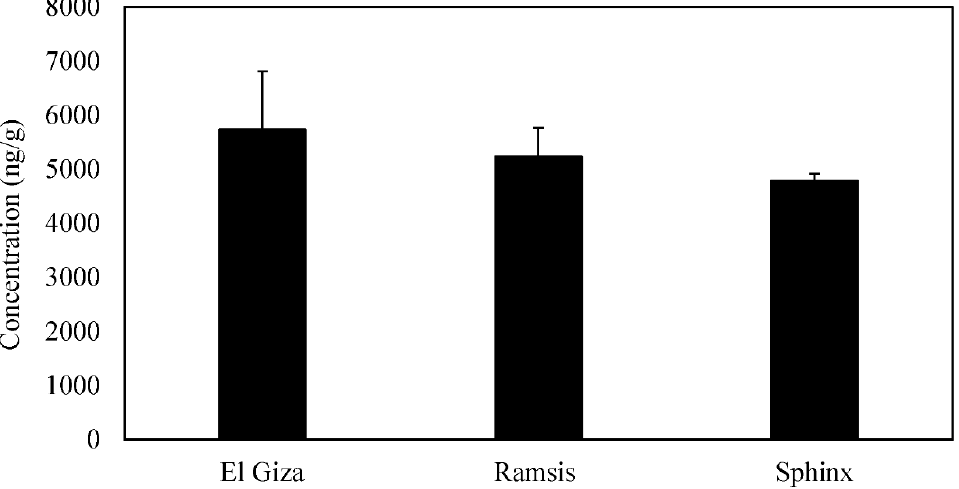
Figure 4. Comparison of the concentrations of the total PAH compounds in total suspended particulate matter collected from El Giza, Ramsis, and Sphinx Square.